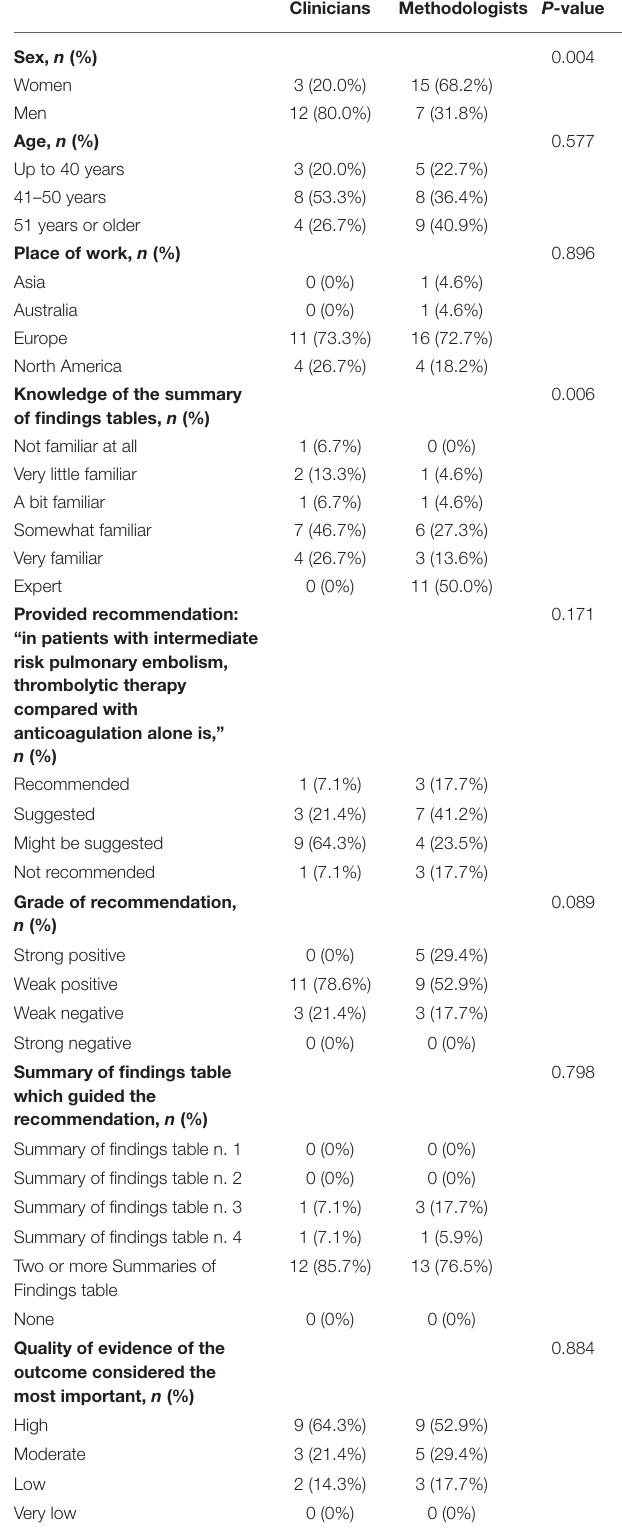
TABLE 3 | Categorized suggestions to revise the summary of findings template in case of overlapping reviews (open-ended response).